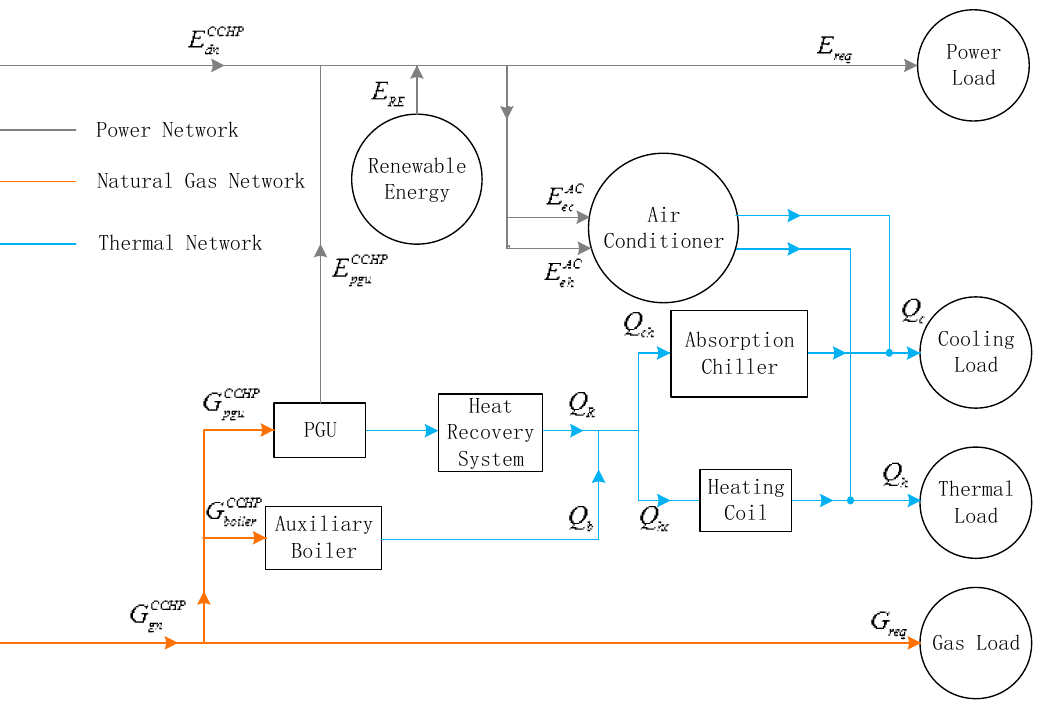
Figure 2. CCHP Physical planning model.